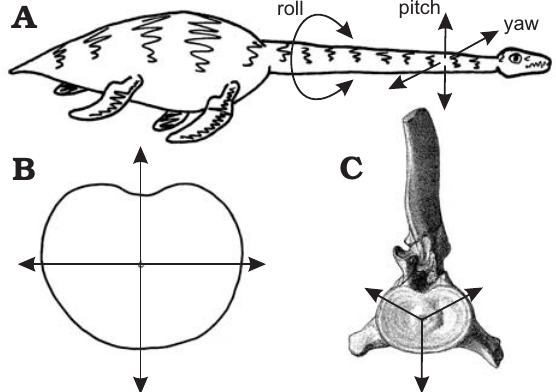
Fig. 10. The range of movement available to the plesiosaur neck. A . Sketch of living or plesiosaur illustrating the three senses of motion (roll, pitch, and yaw) potentially available at each vertebral junction. B . Enhanced dorsoventral movement produced by the laterally expanded articular face of a post-axial cervical vertebrae. Note how more of the same length ar- rows project dorsoventrally than laterally, indicating greater potential for flexibility in dorsoventral pitch that lateral yaw. C . The potential range of movement available at a plesiosaur posterior-cervical vertebra, where freedom of movement is greatest dorsolaterally between the neural spine and cervical ribs, or ventrally between the cervical ribs, in the same way a tripod is more likely to fall over between two of the legs than over one of them. Once the anatomy of the zygapophyses, neural spines, and cervical ribs are taken into account, the movement is restricted to the ventral direc- tion. Images from: C, Andrews (1910: pl. 7: 4); A, B, LFN